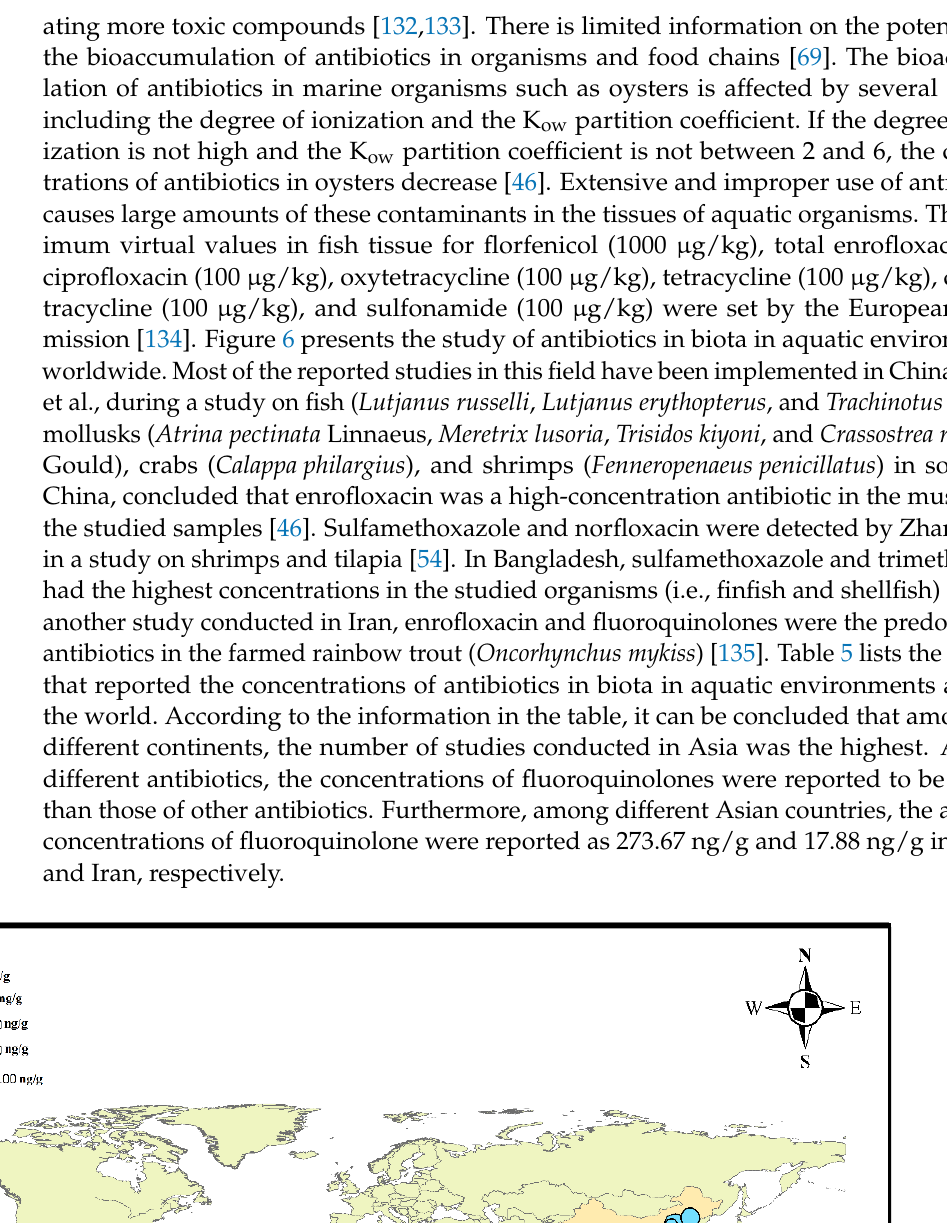
Number of Ref. Stations